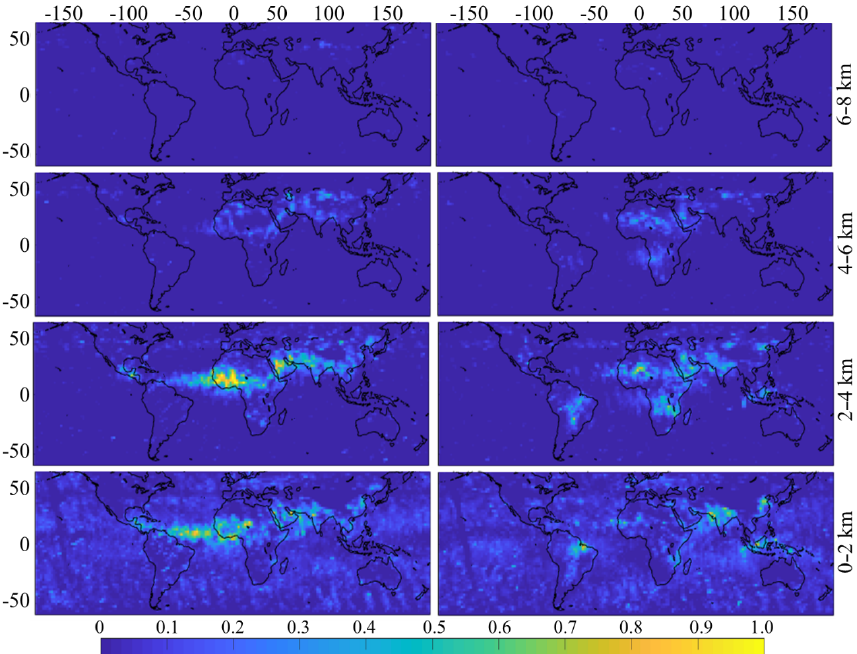
Figure 3. Height-resolved global distributions of aerosol optical depth (AOD) based on construction of RXS-expand 100km on both sides of CALIPSO’s ground track. Left column is for the April dataset, and the right column is for September. Data are binned on a 2 ◦ latitude– longitude grid.